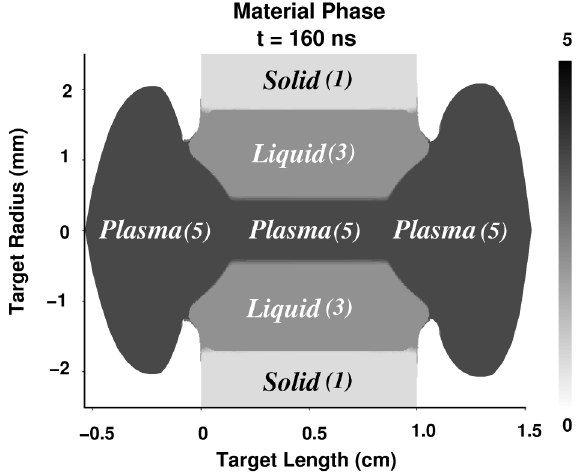
FIG. 14. Matter state at t (cid:3) 160 ns corresponding to the case shown in Fig. 5.